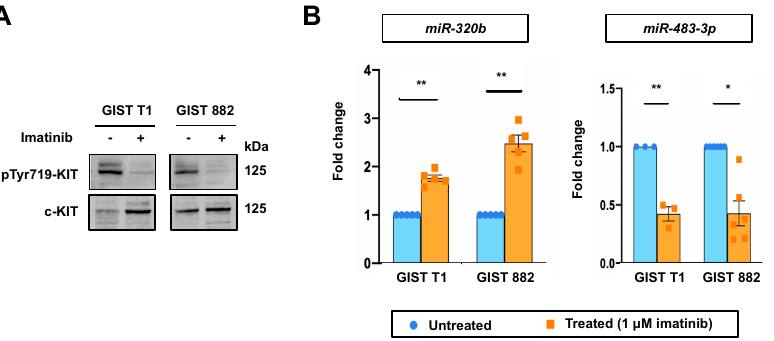
Figure 2. Effect of imatinib treatment on miRNA expressions in GIST cell lines. ( A ) Western blot showing the effectiveness of imatinib treatment in GIST cell lines, as demonstrated by inhibition of KIT phosphorylation. ( B ) RT-qPCR analyses of miR-320b and miR-483-3p were performed in GIST T1 and GIST 882 cell lines after imatinib treatment (1 μ M, 24 h). miRNA expression was normalized to U48 . Fold change refers to the normalized miRNA expression values relative to their respective untreated cells. Differences between groups were calculated using paired t-test. * p < 0.05, ** p < 0.01.